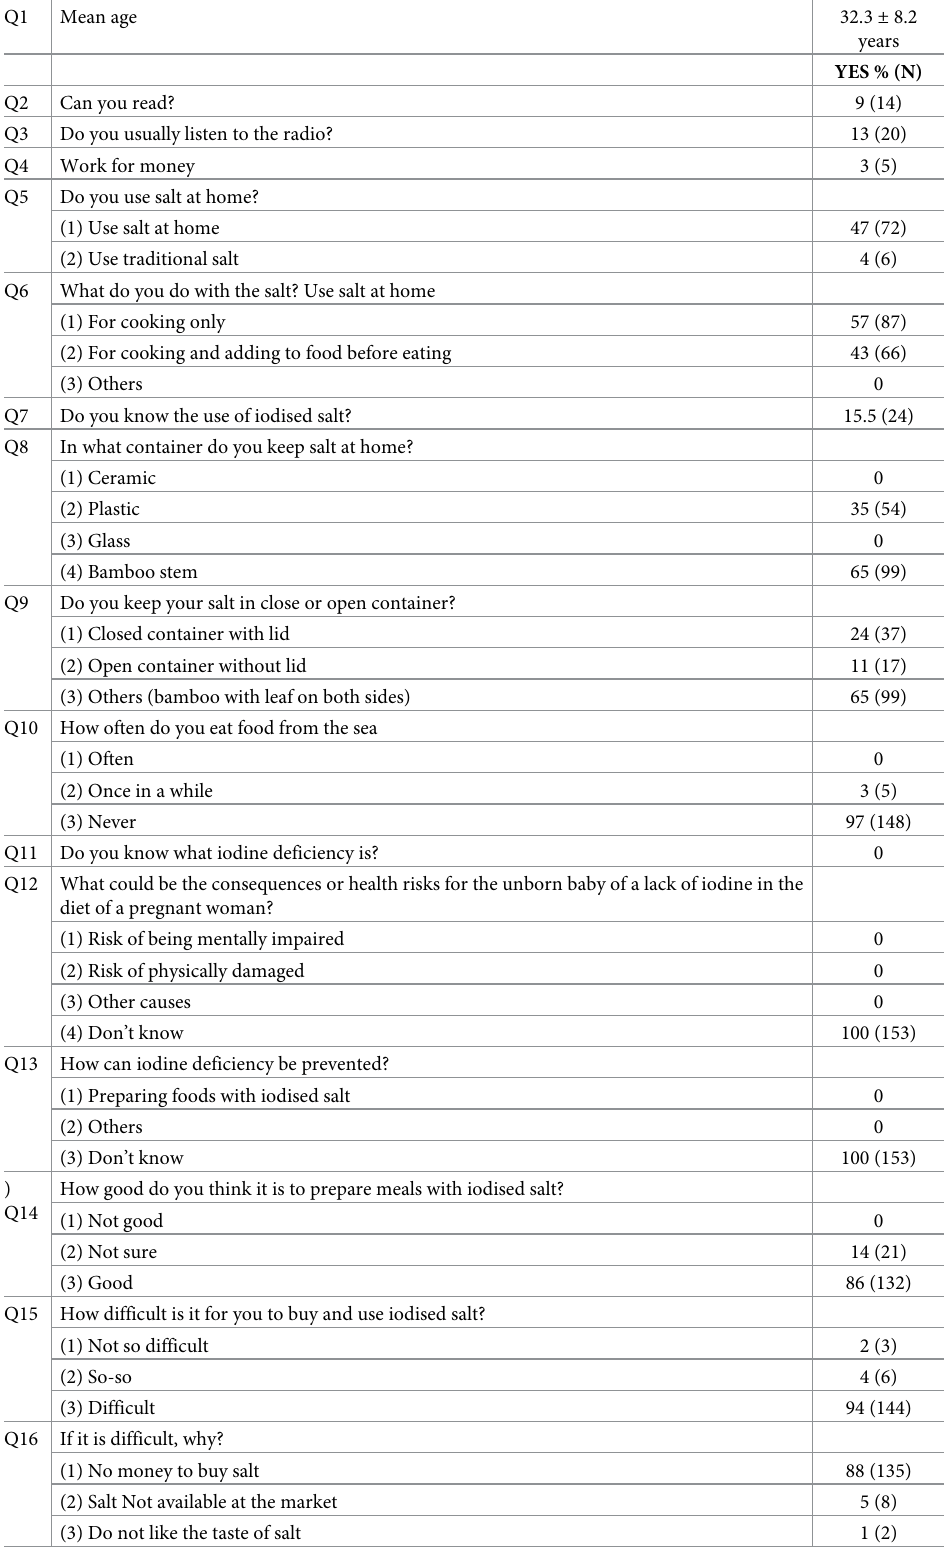
Table 2. Knowledge, attitude, practices of women visiting markets (n =